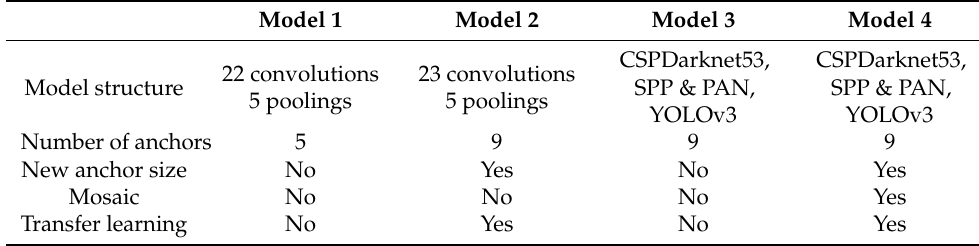
Table 2. The configurations of the recognition